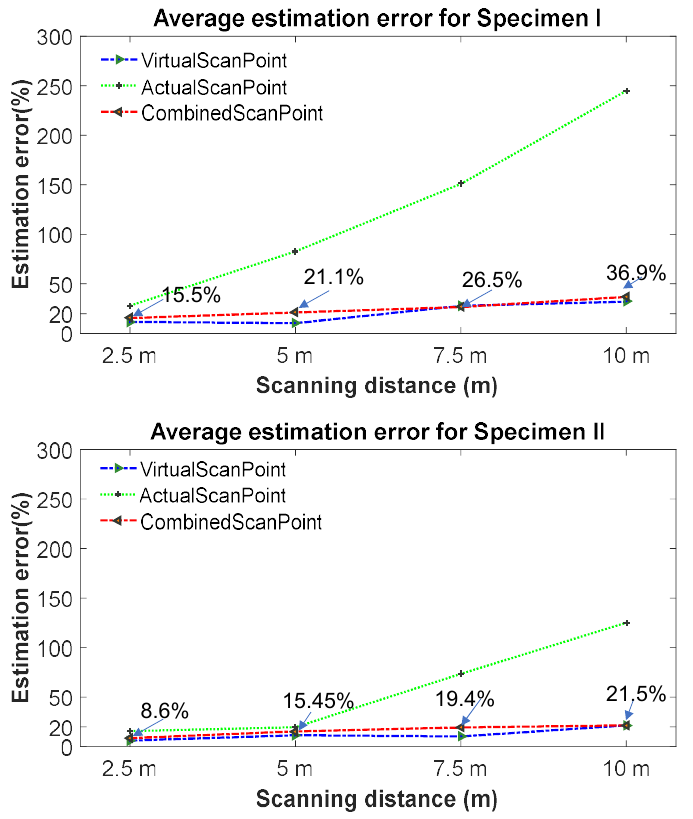
Figure 11. Comparison of F F estimation errors among three types of scan points, including combined scan points, virtual scan points and actual scan points. Table 4. F F number estimation errors under varying angular resolutions for specimens with occlusion problem. Object F F Numbers Estimation Error of Specimen I